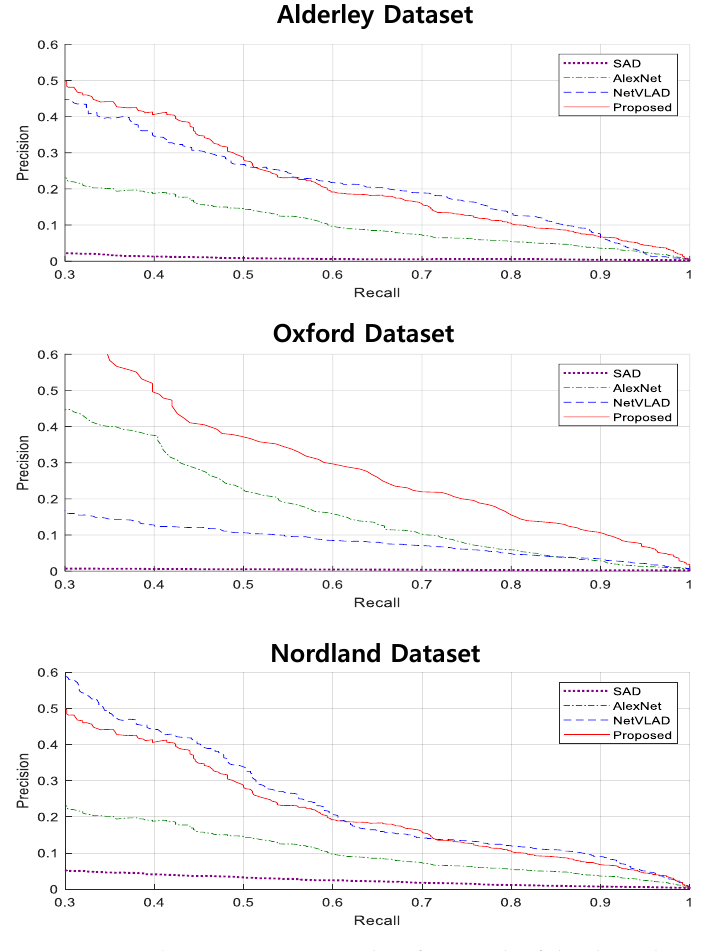
Figure 5. Sample image sequence taken from each of the three datasets: Alderley (day-to-night), Oxford (sunny-to-rainy), and Nordland